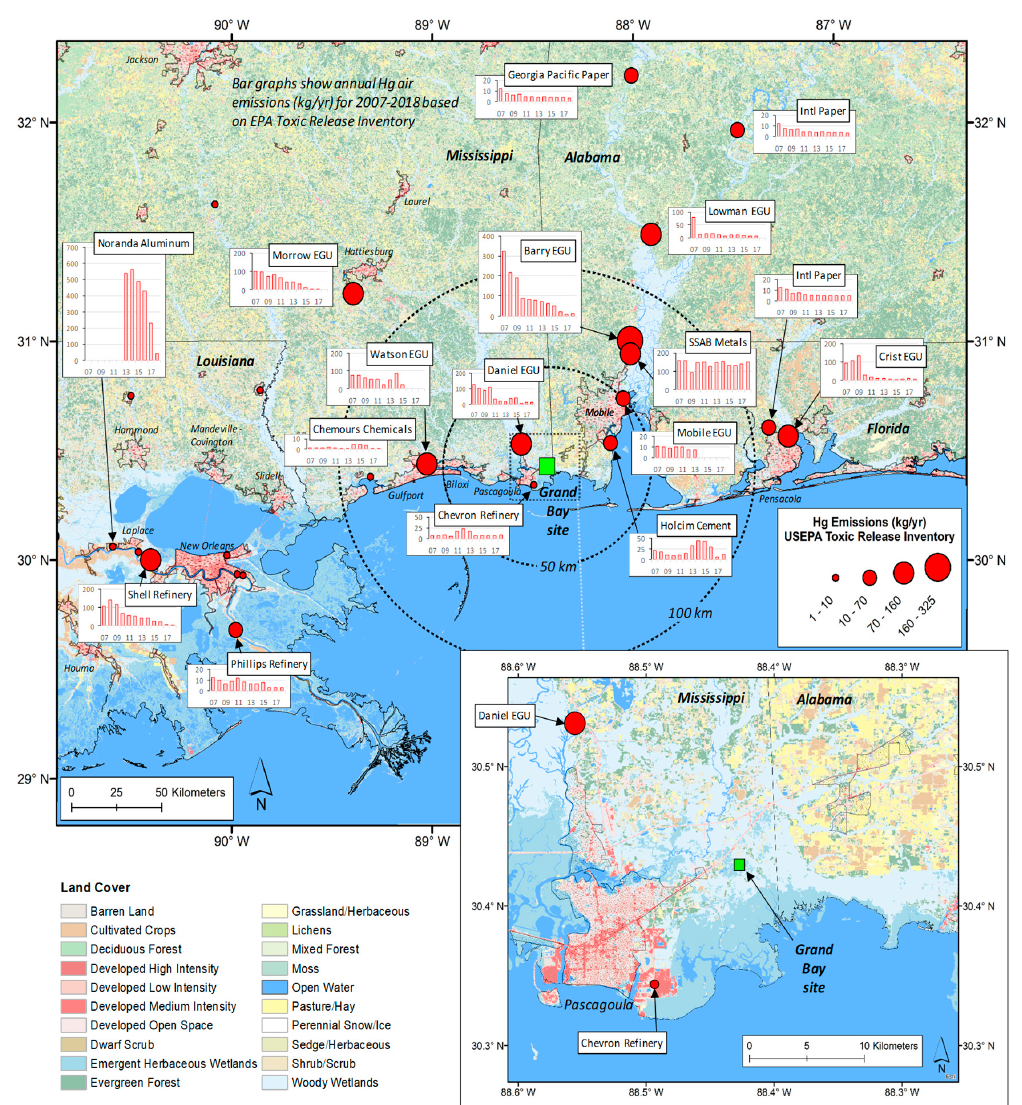
Figure 1. Mercury air emissions point sources in the Grand Bay region based on the Toxic Release Inventory [19]. Symbols on the maps are scaled based on emissions in 2007 and the bar graphs near large and/or nearby sources show the time series of annual mercury emissions from 2007–2018 (kg yr − 1 ). Land cover categories shown on the maps are based on 2011 National Land Cover Database [20].